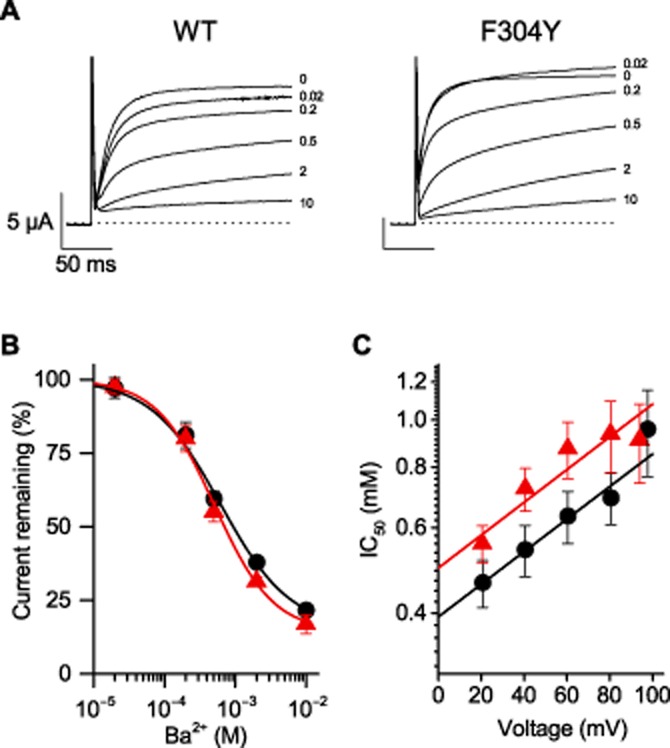
Concentration-dependent inhibition of WT and F304Y mSlo3 currents by Ba2+. (A) Representative traces recorded before (0) and in the presence of Ba2+ (concentrations in mM as indicated). The dashed line represents the zero-current levels and scale bars represent equivalent current amplitudes and timescales. (B) Mean (± SEM) concentration inhibition plots for WT and F304Y mSlo3 at +100 mV, fitted by the Hill equation provided in the Methods. (C) Apparent voltage-dependence of the IC50 for block by Ba2+ of WT and F304Y mSlo3-mediated currents. The data are described and analysed further in the main text. For key to symbols used see Figure 1.